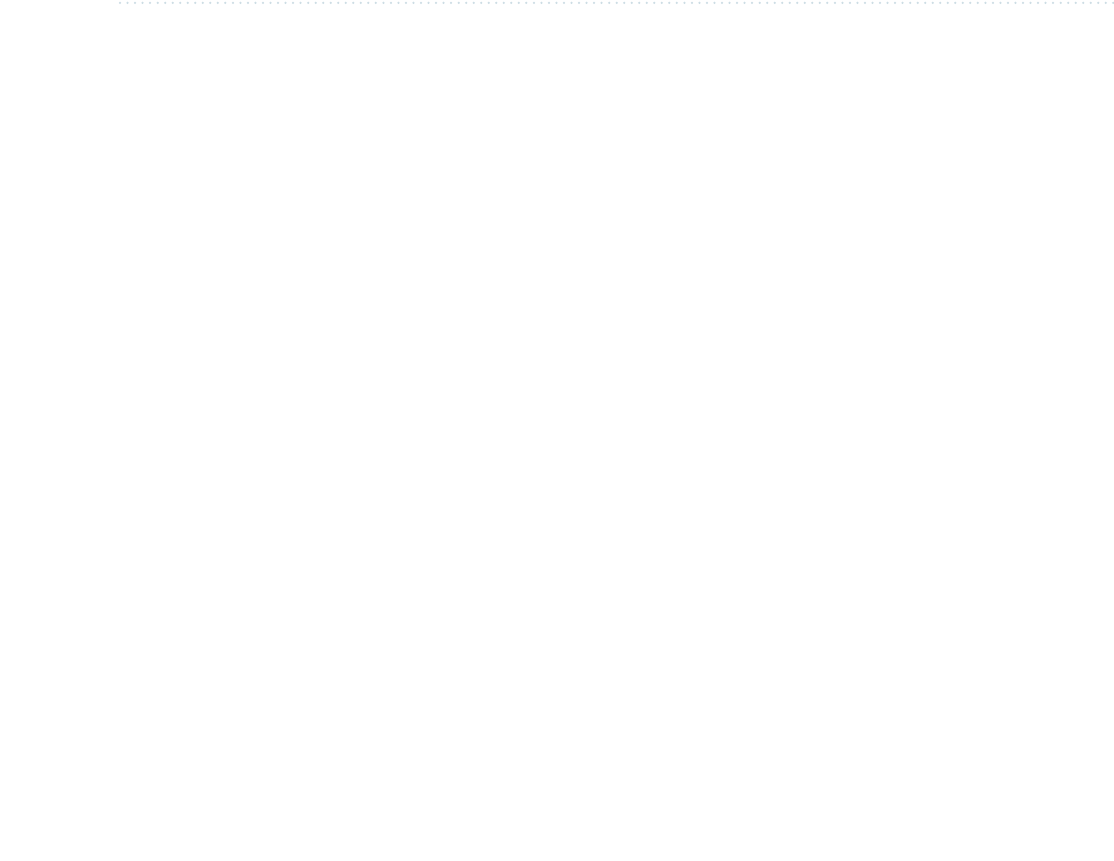
Figure 24. Example